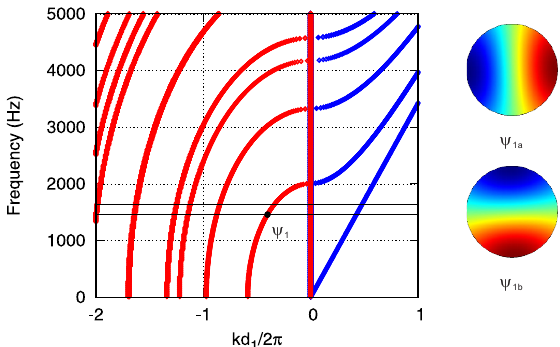
Figure 2. Dispersion relation of the guided modes of an acoustic waveguide of diameter d 1 , obtained by solving for the square of the wavenumber, k 2 , as a function of frequency. Both real (propagating, blue color) and imaginary (evanescent, red color) branches of the dispersion relation are shown. Note that the branches with opposite sign of k exist as well. The cut-off frequency of the first guided mode is 2009 Hz. The two black lines mark the two resonances considered in this work. Pressure distributions for the two degenerate modes at the marked point on the first imaginary branch are shown on the right